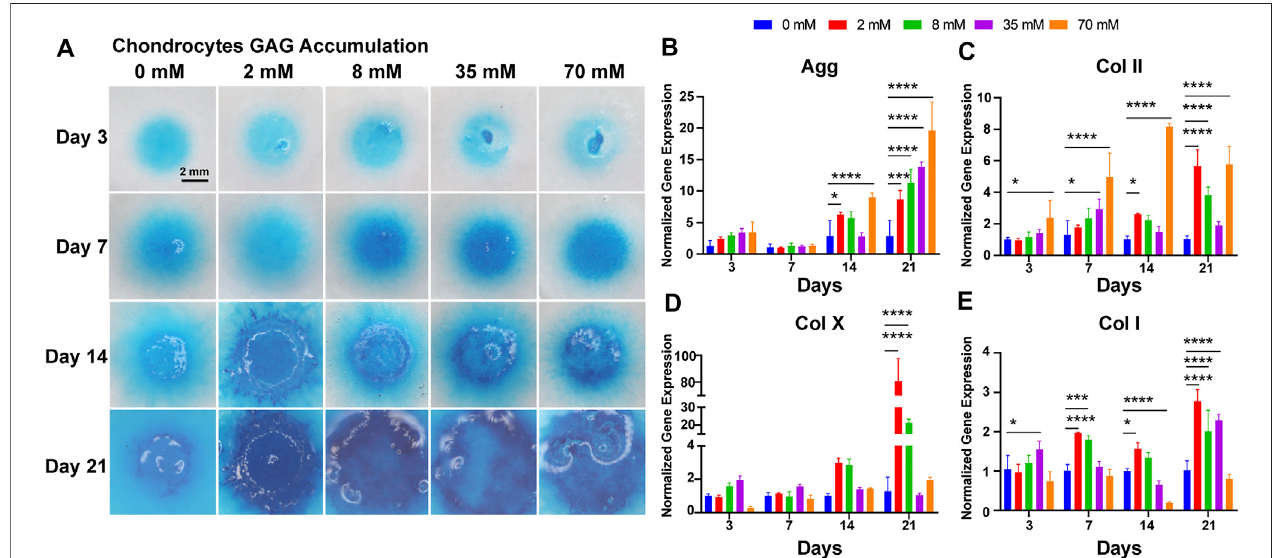
FIGURE3| Chondrogenicphenotypeofchondrocytes. (A) GAGaccumulationofchondrocytes withgalactose treatmentwithin21 days.Scale bar =2 mm. Gene expressionanalysisof (B) aggrecan, (C) collagenII, (D) collagenX,and (E) collagenIwasperformedondays3,7,14,and21.GAPDHwasusedasareferencegene.The fold change of each gene was normalized against the 0 mM group (n = 3, * p < 0.05, ** p < 0.01, *** p < 0.001, and **** p <